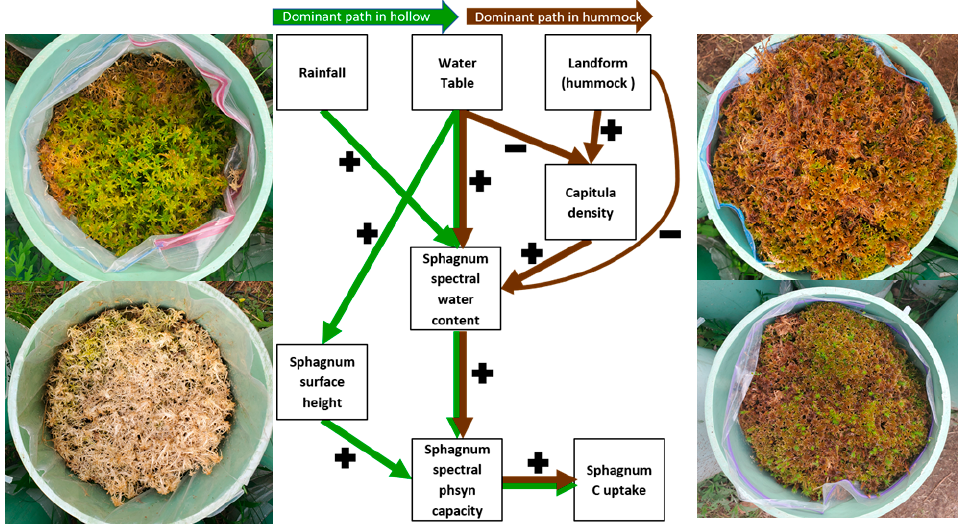
Figure 4. Structural equation model of Sphagnum C uptake (GPP) as a function of the treatments, changes in physical structure, and spectral indicators of Sphagnum spectral water content (Wetness Index) and spectral photosynthetic capacity (“phsyn” in the figure, Chlorophyll Index) (Supplementary File S2, see [36] for greater detail). The box “Landform (hummock)” indicates the effect of the hummock landform relative to the hollow, since that factor is not intrinsically ordered as are the other factors in the SEM. The green arrows indicate the dominant pathway in the hollow landform, while the brown arrows represent the dominant pathway in the hummock landform. (+) symbols represent a positive e ff ect, ( − ) symbols a negative e ff ect. Non-significant pathways have been excluded for clarity. Photos to the left represent the response to drying of Hollow landforms, while photos to the right represent the response to drying of the Hummock landform. SEM statistical output is presented in Table 1.